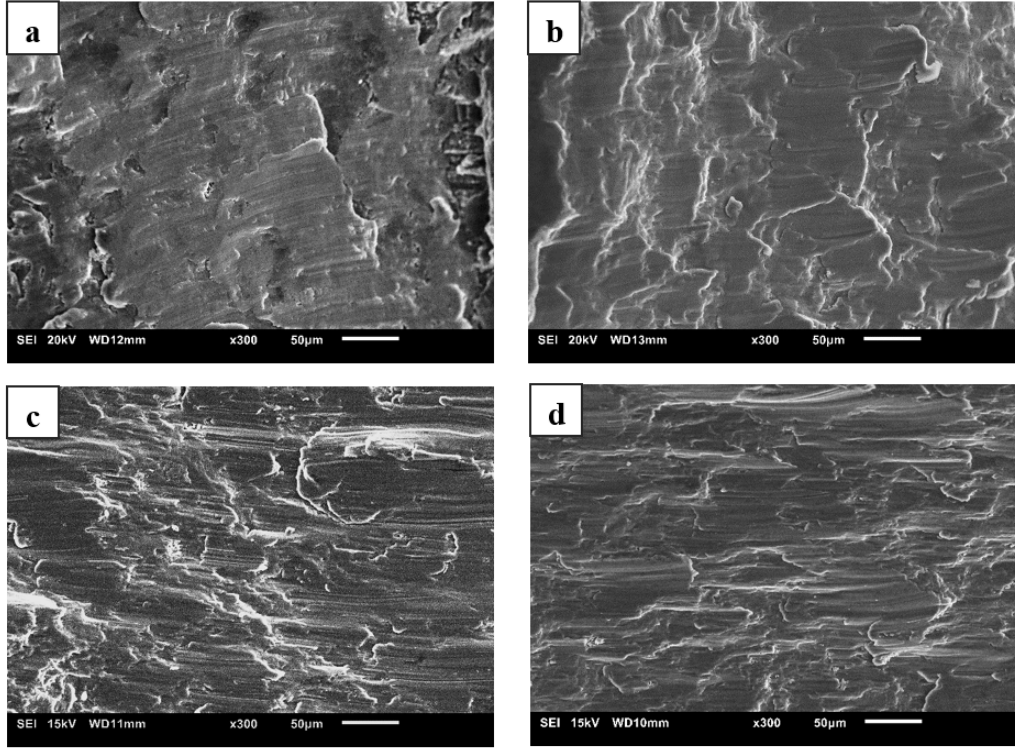
Figure 7. Representative fractographs of: ( a ) Mg; and the ( b ) Mg-2.5CCA; ( c ) Mg-5CCA; and ( d ) Mg- 7.5CCA